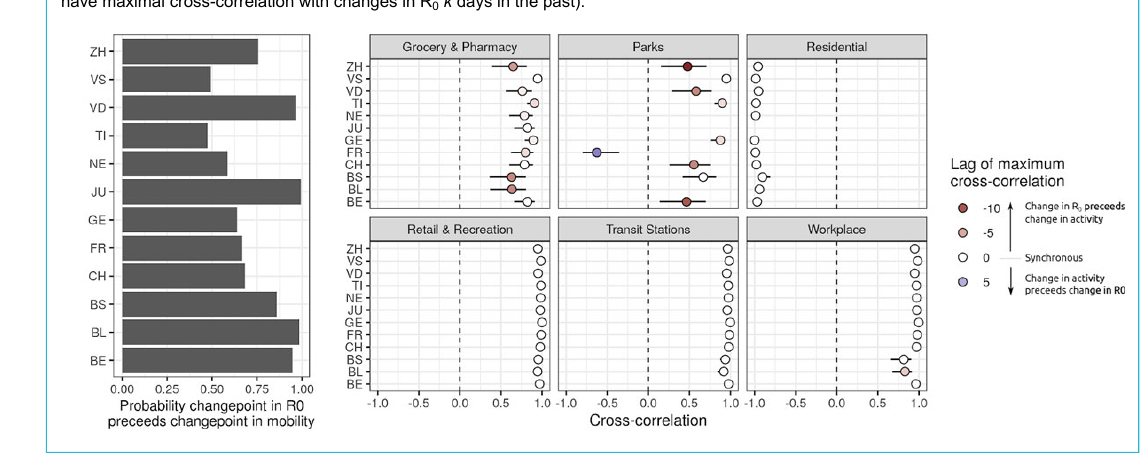
Figure 4: Timing between changes in R 0 and mobility. Left: probability that the first changepoint in R 0 occured before the first changepoint in mobility-related activity. Right: Maximum cross-correlations between time series of changes in R 0 and changes in mobility (bars 95% CI). Lags refer to the delay between changes in mobility-related activity and changes in R 0 (positive lag k indicates that current changes in mobility have maximal cross-correlation with changes in R 0 k days in the